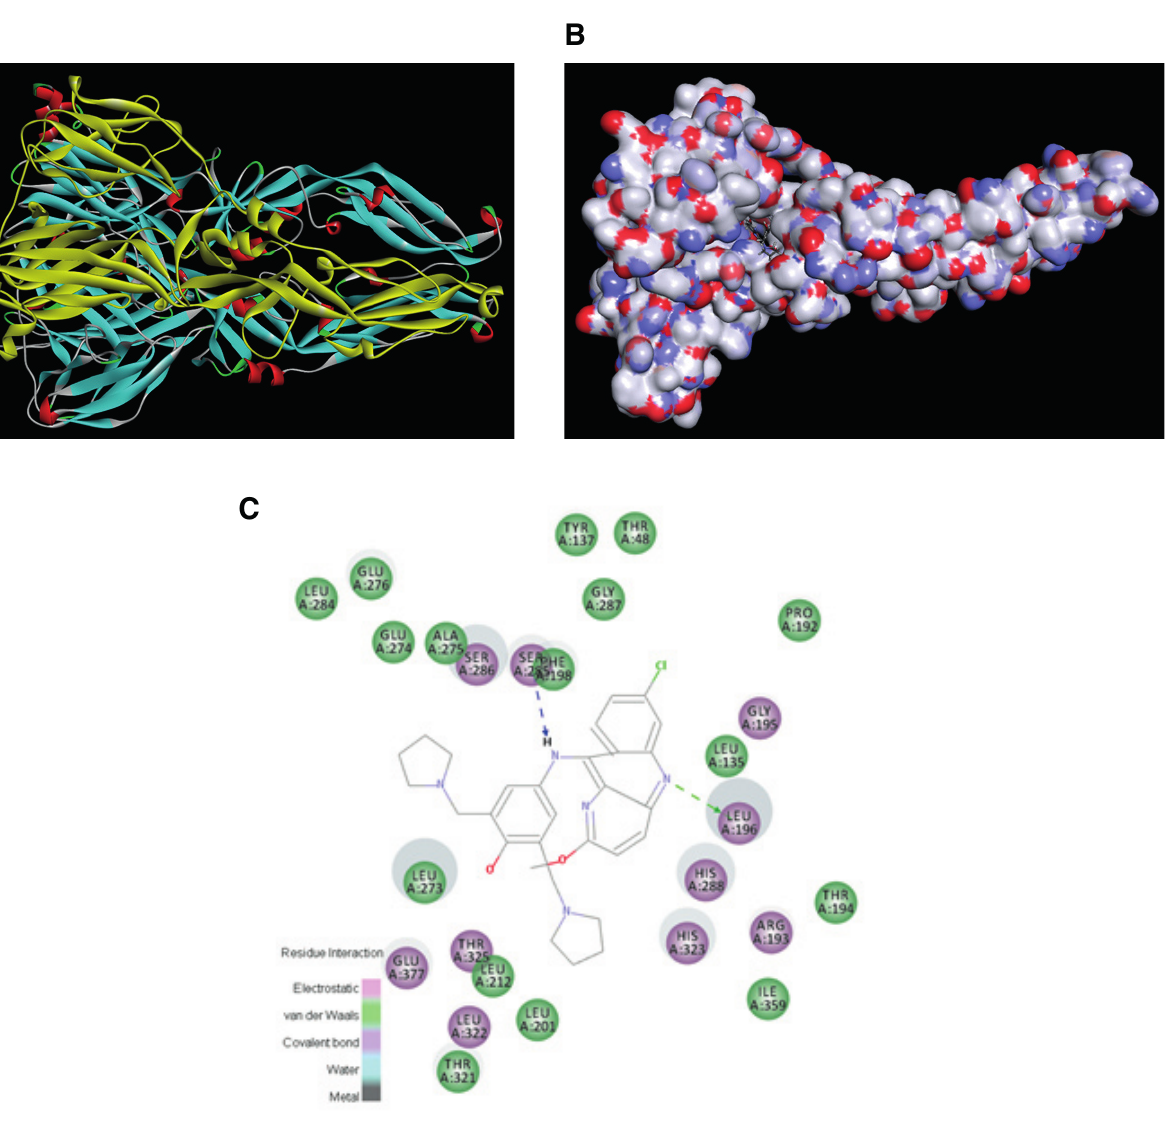
Figure 2. Homology model created for the Zika virus envelope protein. A . Complete protein shown as a ribbon diagram (generated in Discovery Studio). B . Pyronaridine shown docked into the subunit A homology model, small molecule colored by atom, protein colored by atom charge. C . 2D interaction plot for